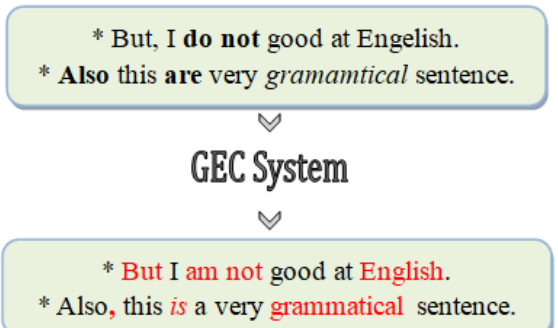
Figure 1. An example of an automatic grammatical error correction